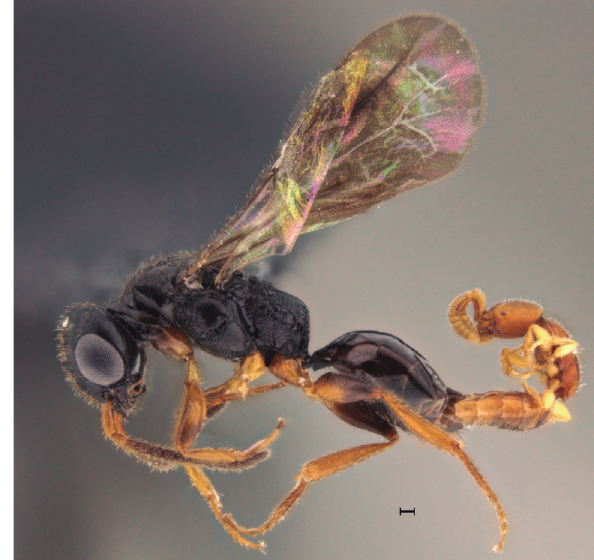
Figure 13. Male and female of Dissomphalus rettenmeyeri from Panama coupled in position of phoretic copulation as during in copula. Scale bars: 100 µm.